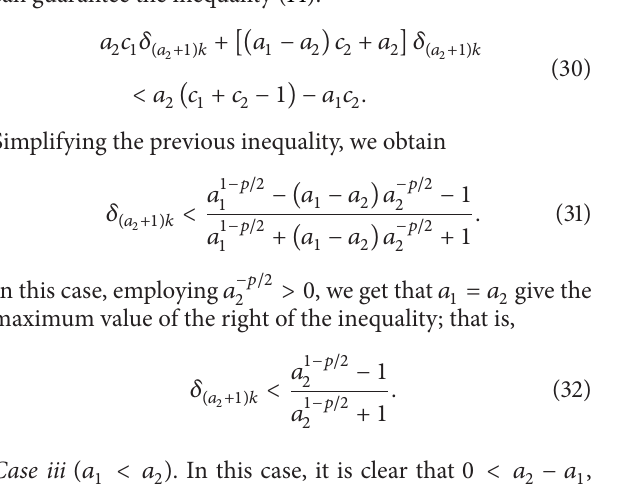
Figure 1: Theupper bound of 𝑝 -RICoforder (𝑎+1)𝑘 with particular values of 𝑝